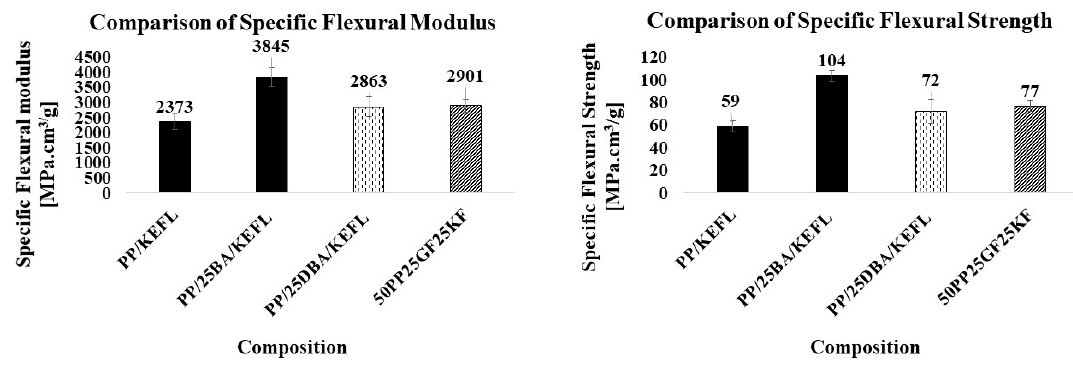
Figure 4. Flexural analysis of bast/basalt and bast/GF hybrid composite and a comparison with reference composite PP/KEFL.